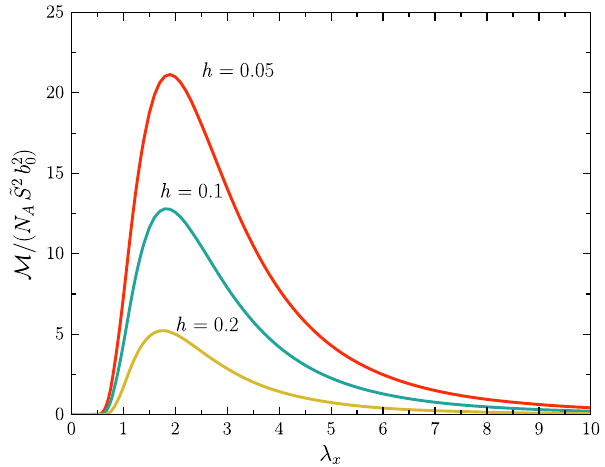
0 . 1 at D ¼ 2 (a), D ¼